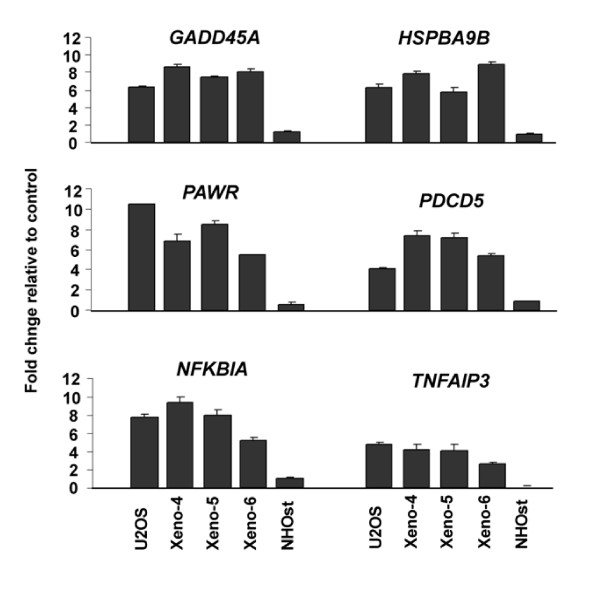
Real-time gene expression of 6 pro-apoptotic genes U2OS in vitro &in vivo and normal osteoblasts. Total RNA was extracted from U2OS cells in vitro and in vivo and reverse-transcribed as detailed in methods. TaqMan assays were used to determine relative expression using the cDNA from control (no treatment) as base lines and ACTB for a reference gene by applying the ΔΔCt method. Each column is the Mean of three replicas and error bars indicate standard deviation from the Mean. The data is expressed as fold change relative to control (no-treatment). Xeno-4, Xeno-5, and Xeno-6 = decitabine treated xenografts. NHOst = normal human osteoblasts.